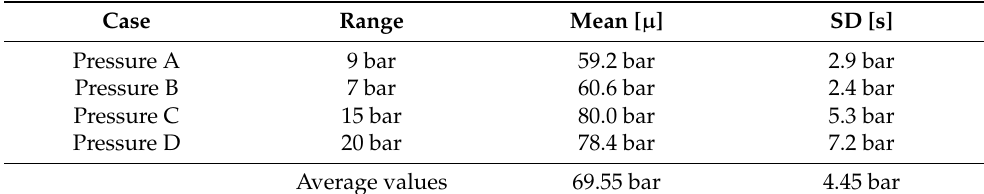
Table 3. Variability of the experiments 1 to